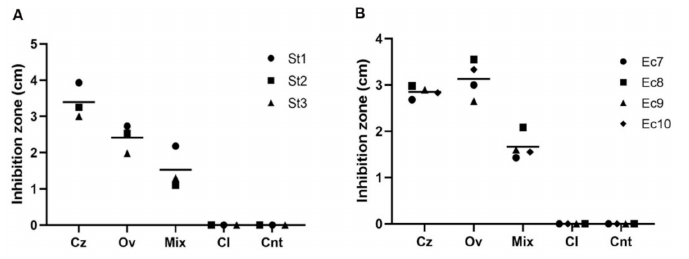
Figure 1. Micro-atmosphere diffusion assay: ( A ). Plot shows inhibition zones of Salmonella strains; ( B ). Plot shows inhibition zones of E. coli strains.